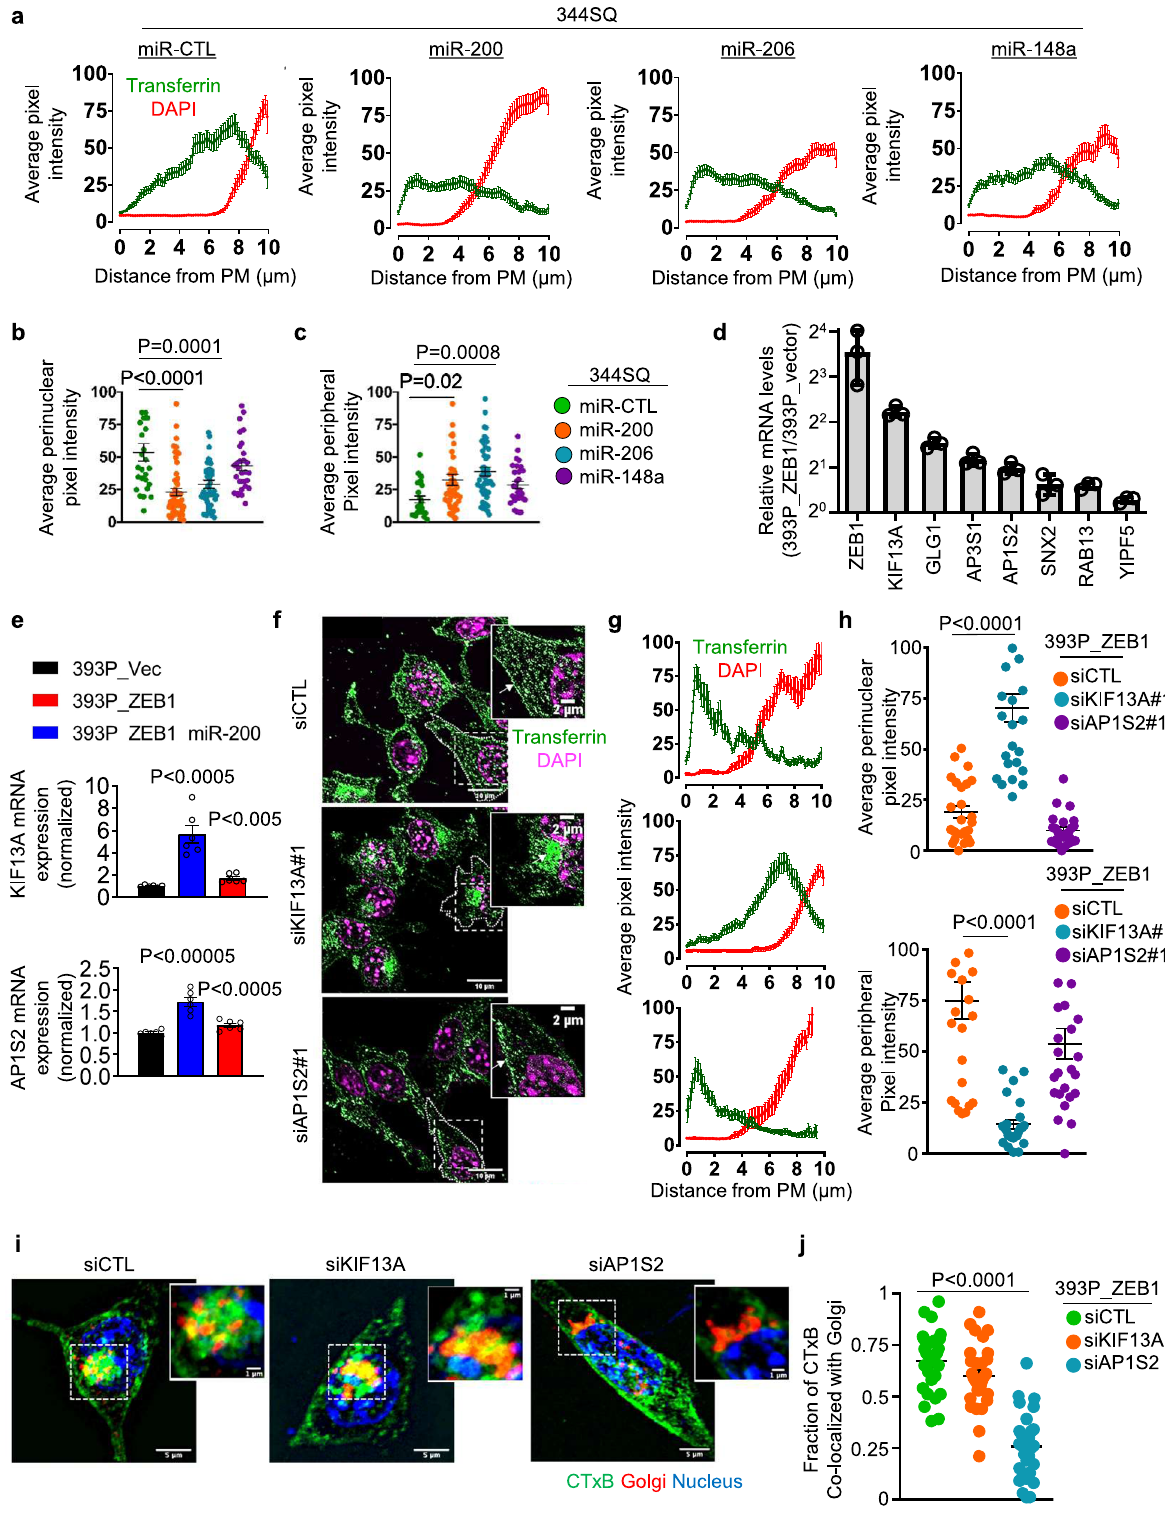
Cell migration and invasion assays in Boyden chambers . As described previously 2 , migration and invasion assays were performed in Transwell and Matrigel-coated Boyden chambers, respectively. For single-cell tracing assays, 1× 10 4 cells per well were seeded on fi bronectin-coated, glass-bottom 24-well plates. Cells were imaged at 5-min intervals for 24h in DIC mode using a 20× 0.75 NA Air objective on an Eclipse TiE inverted microscope (Nikon) using NIS Ele- ments V4.40 software. For Boyden chambers, 2 ×10 4 cells were seeded in the upper wells of Transwell and Matrigel chambers, respectively (BD Biosciences) and